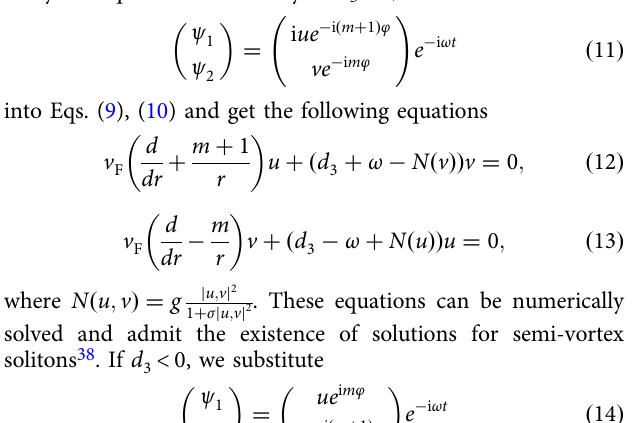
ffiffiffiffiffiffiffiffiffiffiffiffiffiffiffiffi